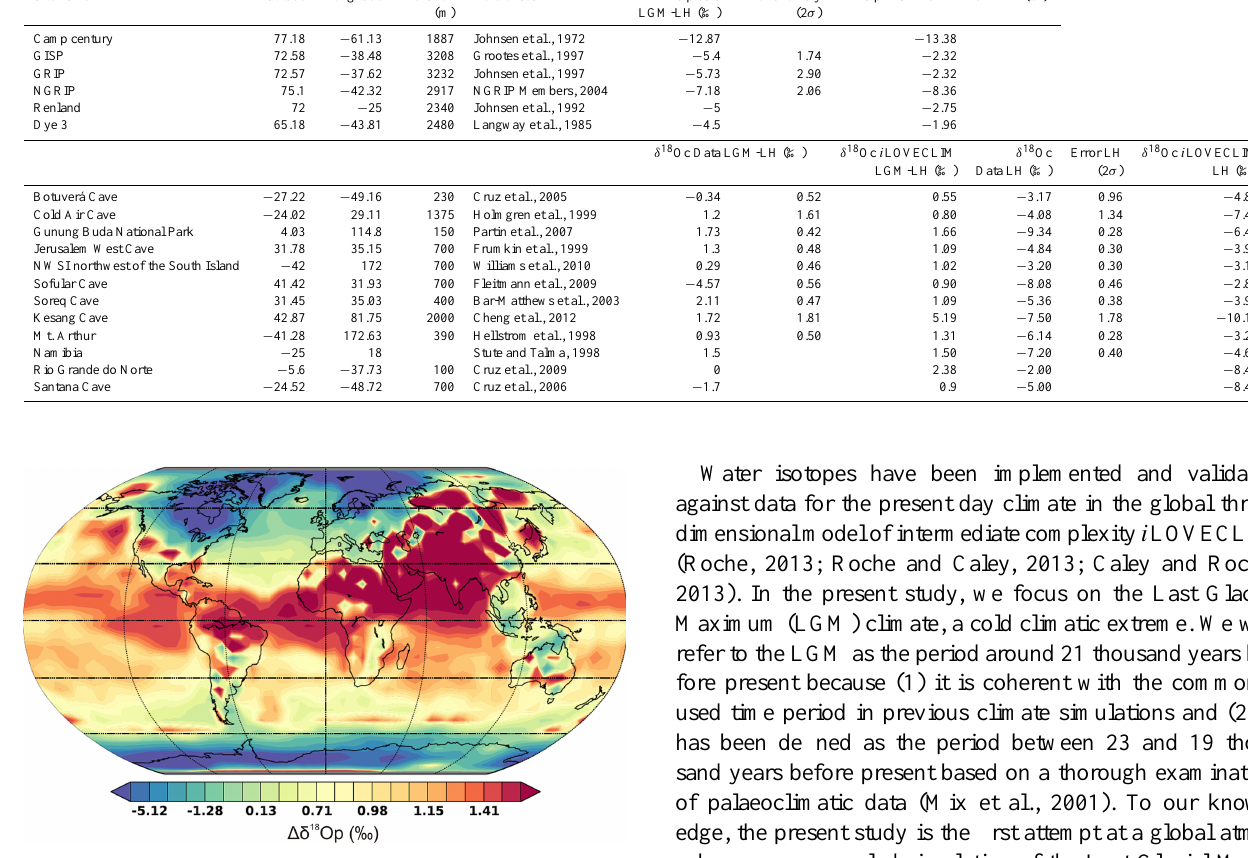
Figure 1. Simulated precipitation δ 18 O anomaly (LGM-CT) in i LOVECLIM. The colour scale is based on the distribution of the values in the data set used: 95% of the proxy data are meant to be appropriately represented in that colour scale. It is centred around the mean of the data set, hence red represents heavier values than the mean and blue represents lighter values than the mean of the data